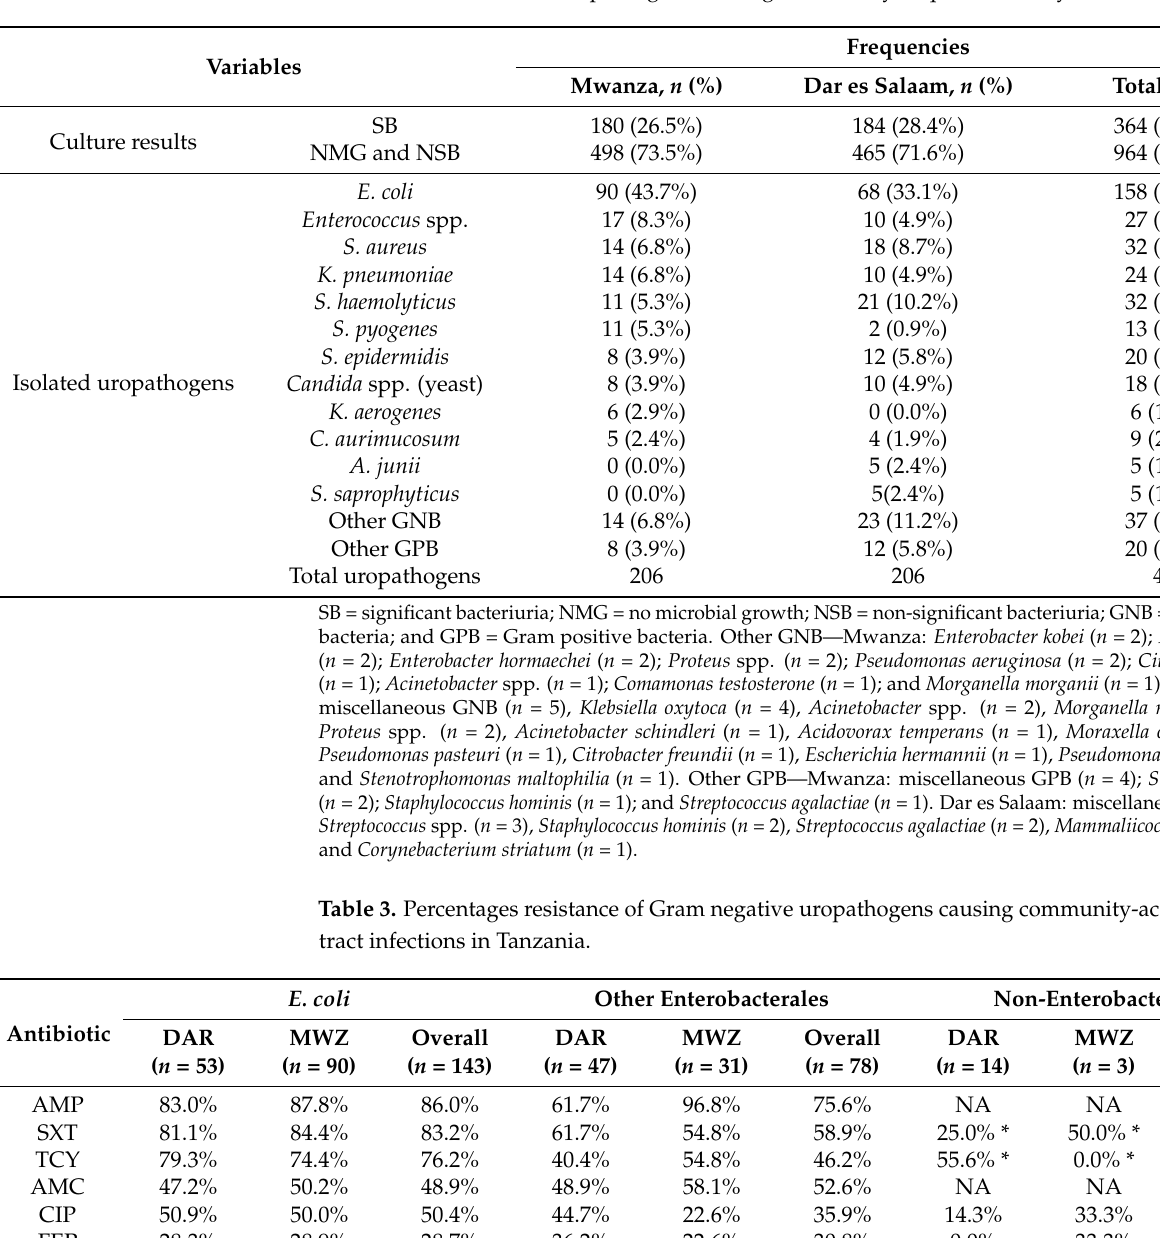
Table 2. Distribution of uropathogens causing community-acquired urinary tract infections.